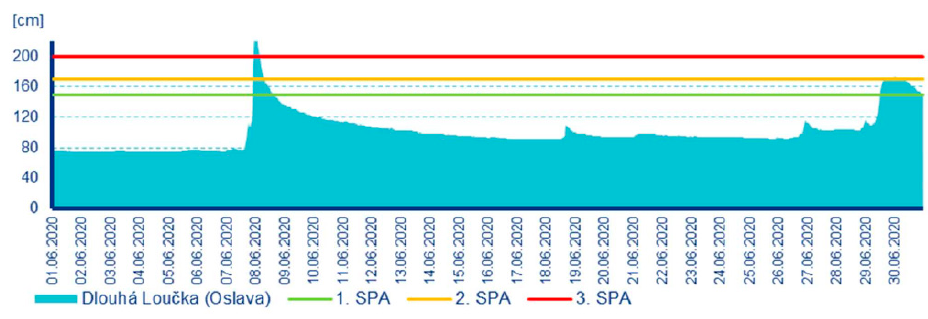
Figure 10. The water level at Dlouhá Lou č ka station on the river Oslava during June 2020. SPA corresponds to level of flooding activity. Source: [32].